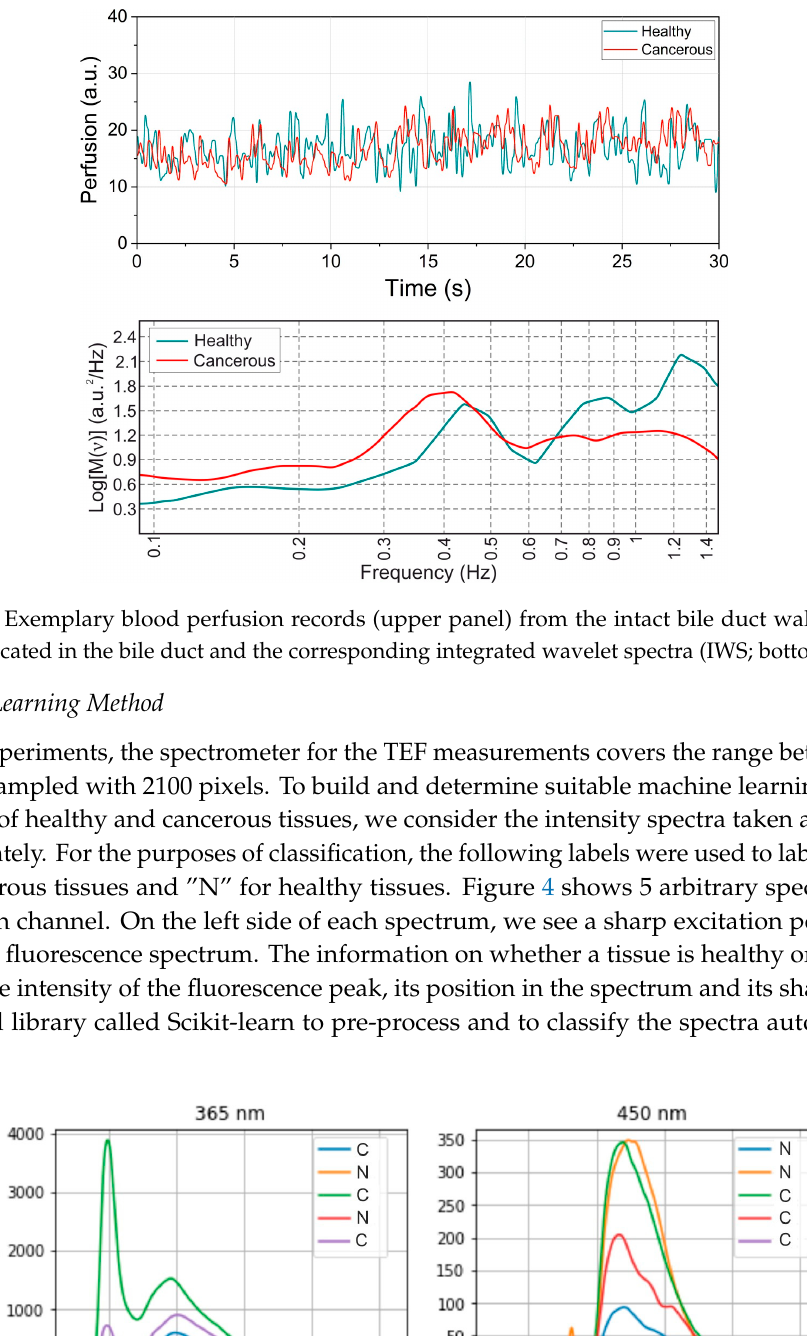
Figure 4. 5 arbitrary fluorescence spectra and their labels obtained at the excitation channel of 365 nm (left) and 450 nm (right). In these graphs, the label “N” denotes a normal tissue whereas “C” a cancerous tissue.